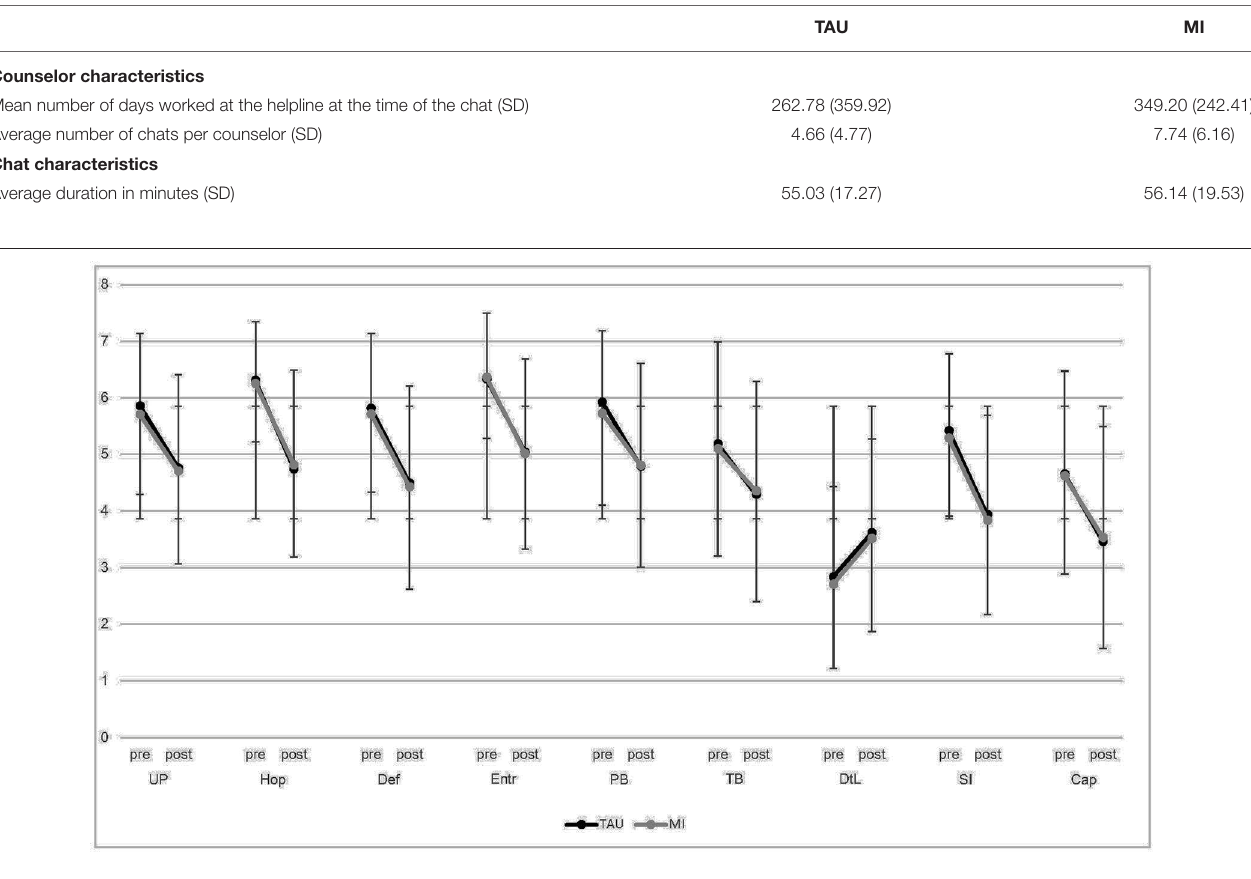
FIGURE 3 | Means and standard deviations of pre- and post-chat scores for all suicide risk factors. SI, Suicidal ideation; UP, Unbearable psychache; Hop, Hopelessness; Def, Defeat; Entr, Entrapment; PB, Perceived burdensomeness; TB, Thwarted belongingness; DtL, Desire to live; Cap, Capability for